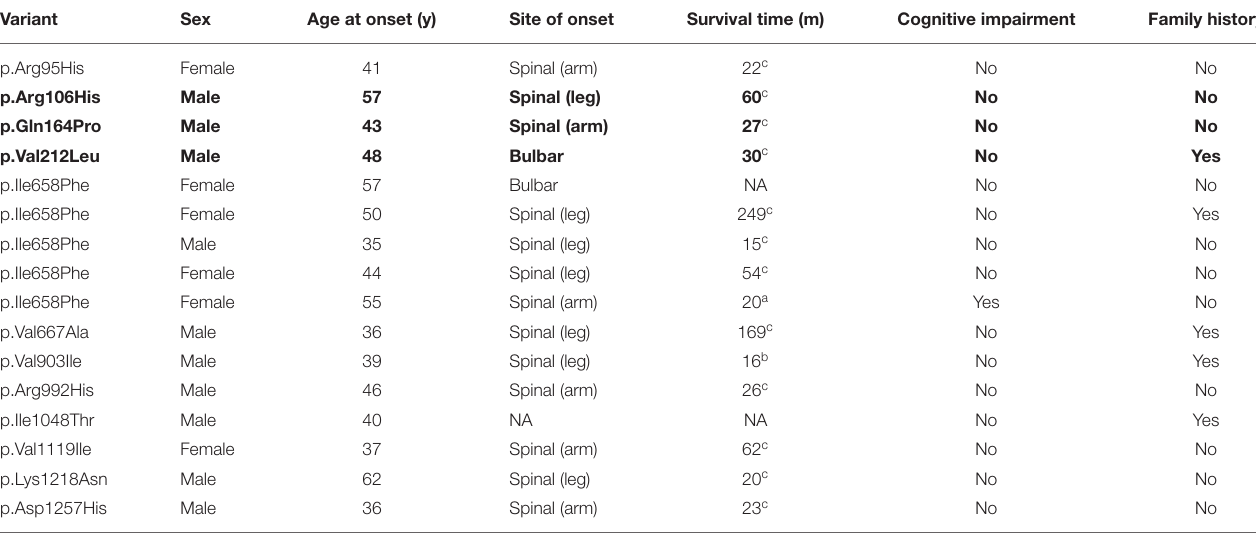
TABLE 3 | Clinical information of the 16 unrelated ALS patients with 12 missense variants.